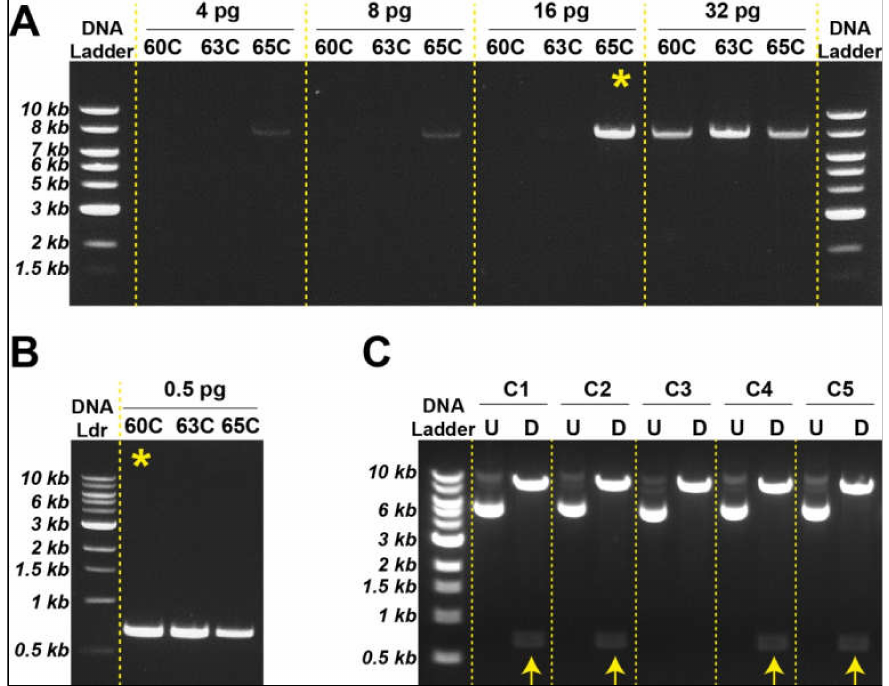
Figure 2. Generation of lentiviral plasmids with different fluorescent protein genes ( A ). Optimum template DNA and annealing temperature is determined to synthesize empty vector (pLVX). The most advantageous tested condition is indicated with a yellow asterisk ( B ). Minimal DNA template was used to synthesize insert (E2-Crimson). The most advantageous tested condition is indicated with a yellow asterisk ( C ). Restriction digestion with XhoI and EcoRI identified the newly engineered plasmids with correct DNA sizes (indicated by yellow